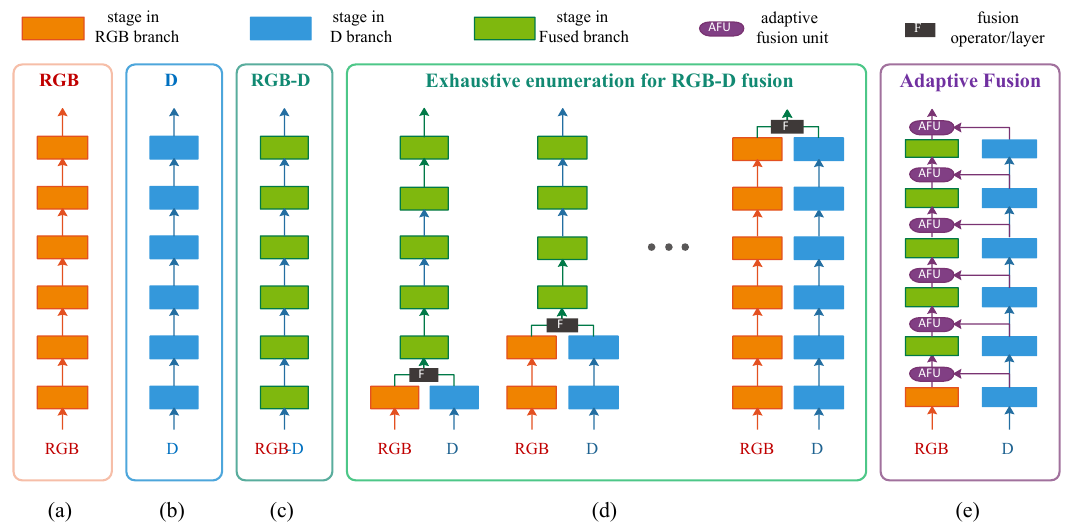
Figure 3. An illustration of different fusion schemes: ( a ) network for RGB channels, ( b ) network for D channel, ( c ) directly concatenation of RGB-D channels, ( d ) an exhaustive enumeration of fusion levels [20], and ( e ) our proposed adaptive fusion network (AF-Net). Noted that the figure is for illustrative purpose, and the actual number of stages in networks may vary according to different network